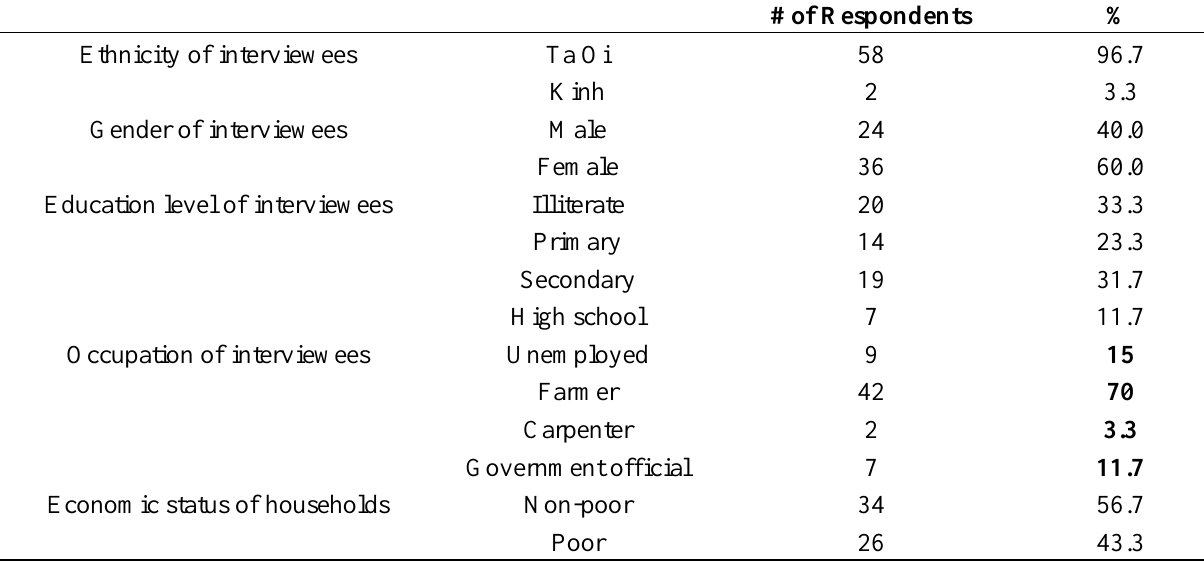
Table 1. Information of respondents represented to interviewed households ( n = 60). Source: Authors’ household survey,